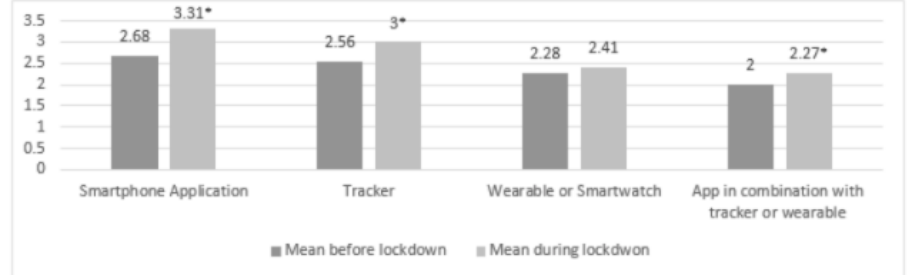
Figure 5. Mean scores of technological supports (5-point Likert Scale). * = significant increase in comparison with before the lockdown.